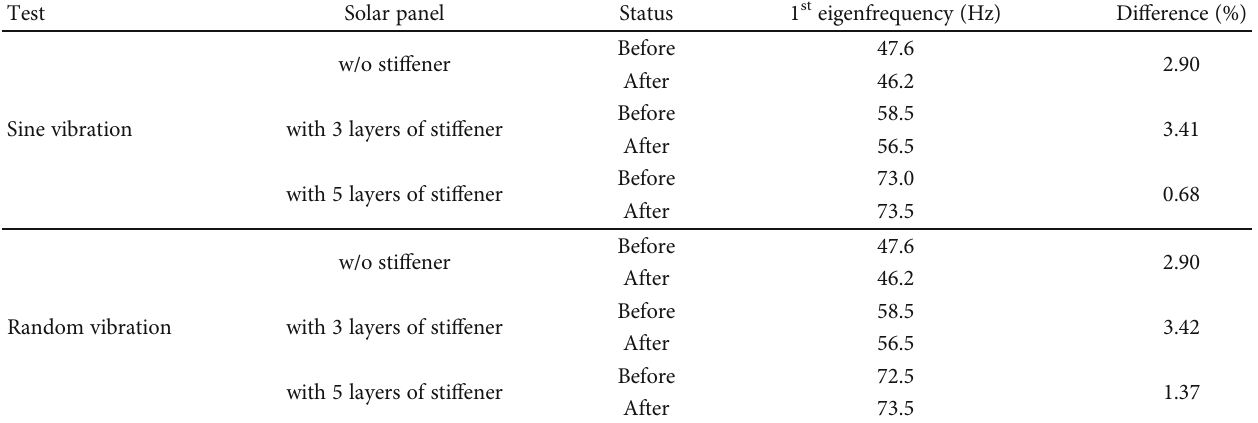
Table 4: LLSS test results of solar panels before and after full level vibration test.